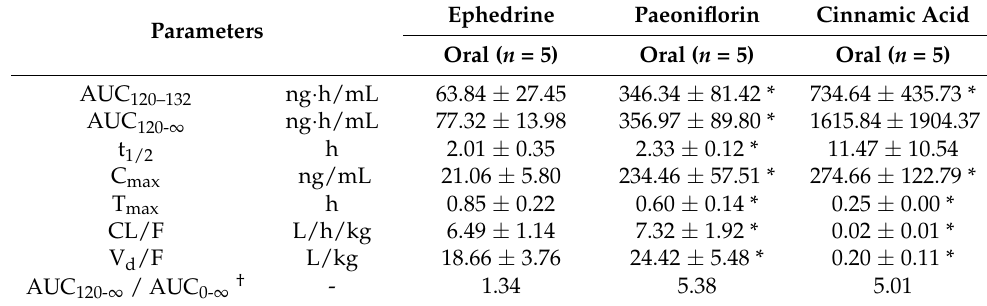
Table 3. Main pharmacokinetic parameters for the three components in rats after multiple oral administrations of SCRT containing 0.49 mg/kg of ephedrine, 2.475 mg/kg of paeoniflorin, and 0.0125 mg/kg of cinnamic acid. All data are presented as the mean ±